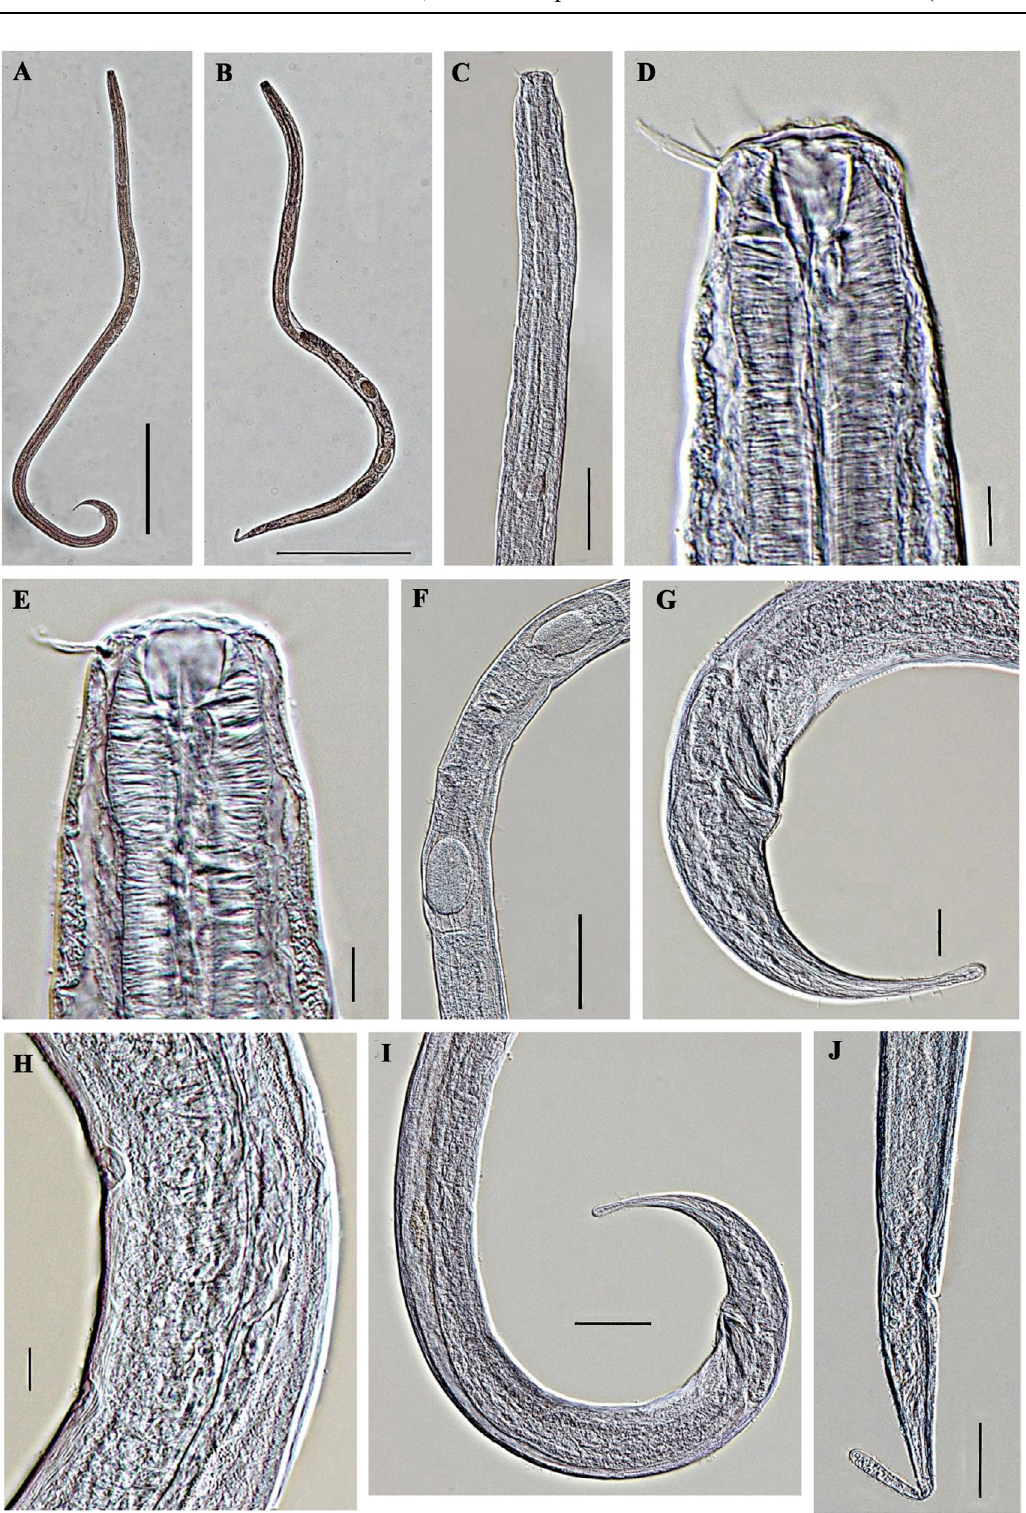
Fig. 2. Tobrilus elginus sp. nov., light micrographs. A . Entire male. B . Entire female. C . Male pharyngeal region. D . Male anterior end. E . Female anterior end. F . Female vulva region. G, I . Male posterior body end. H . Male supplement region. J . Female posterior body end. Scale bars: A–B = 500 µm; C, F = 100 µm; D–E, H = 10 µm; G = 20 µm; I–J = 50